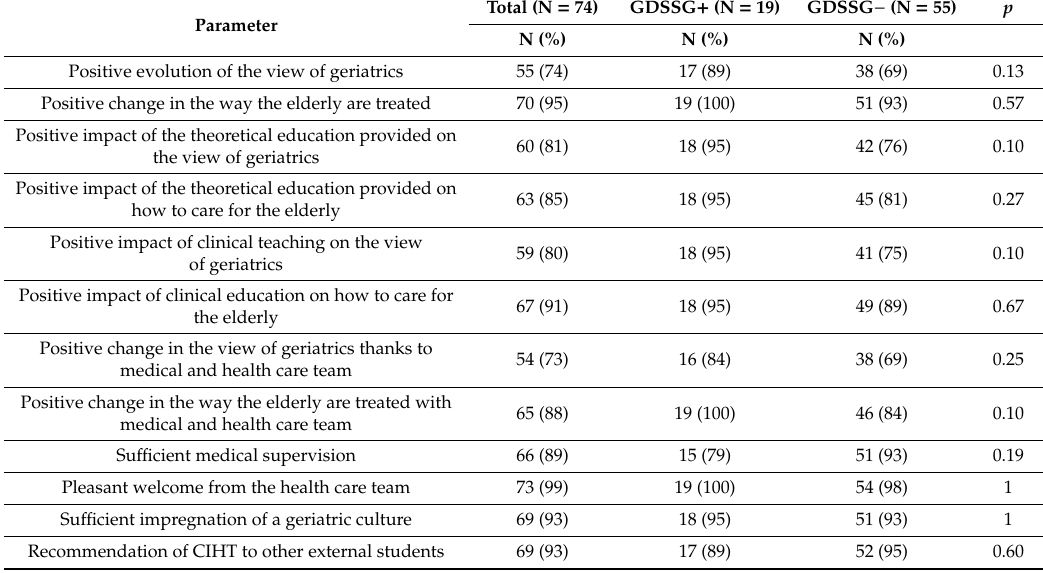
Table 5. Impact of in-hospital training on students’ view of